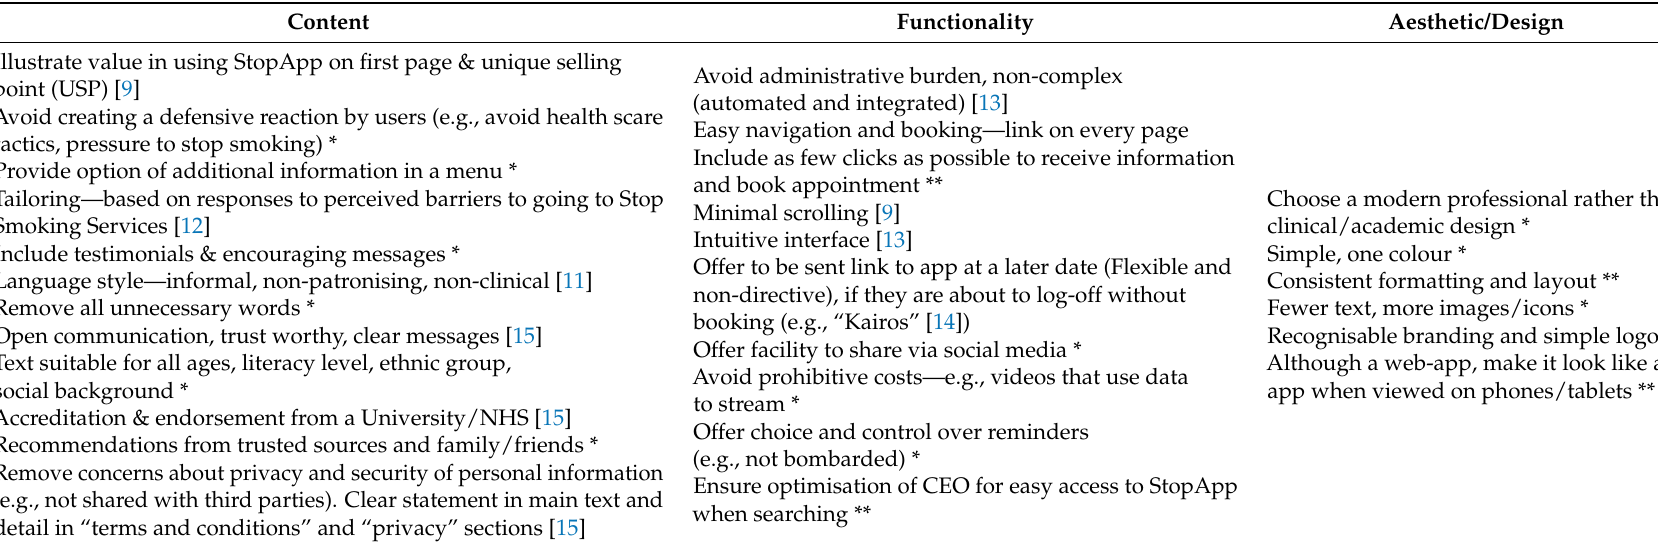
Table 2. Content, functionality and design factors considered necessary for